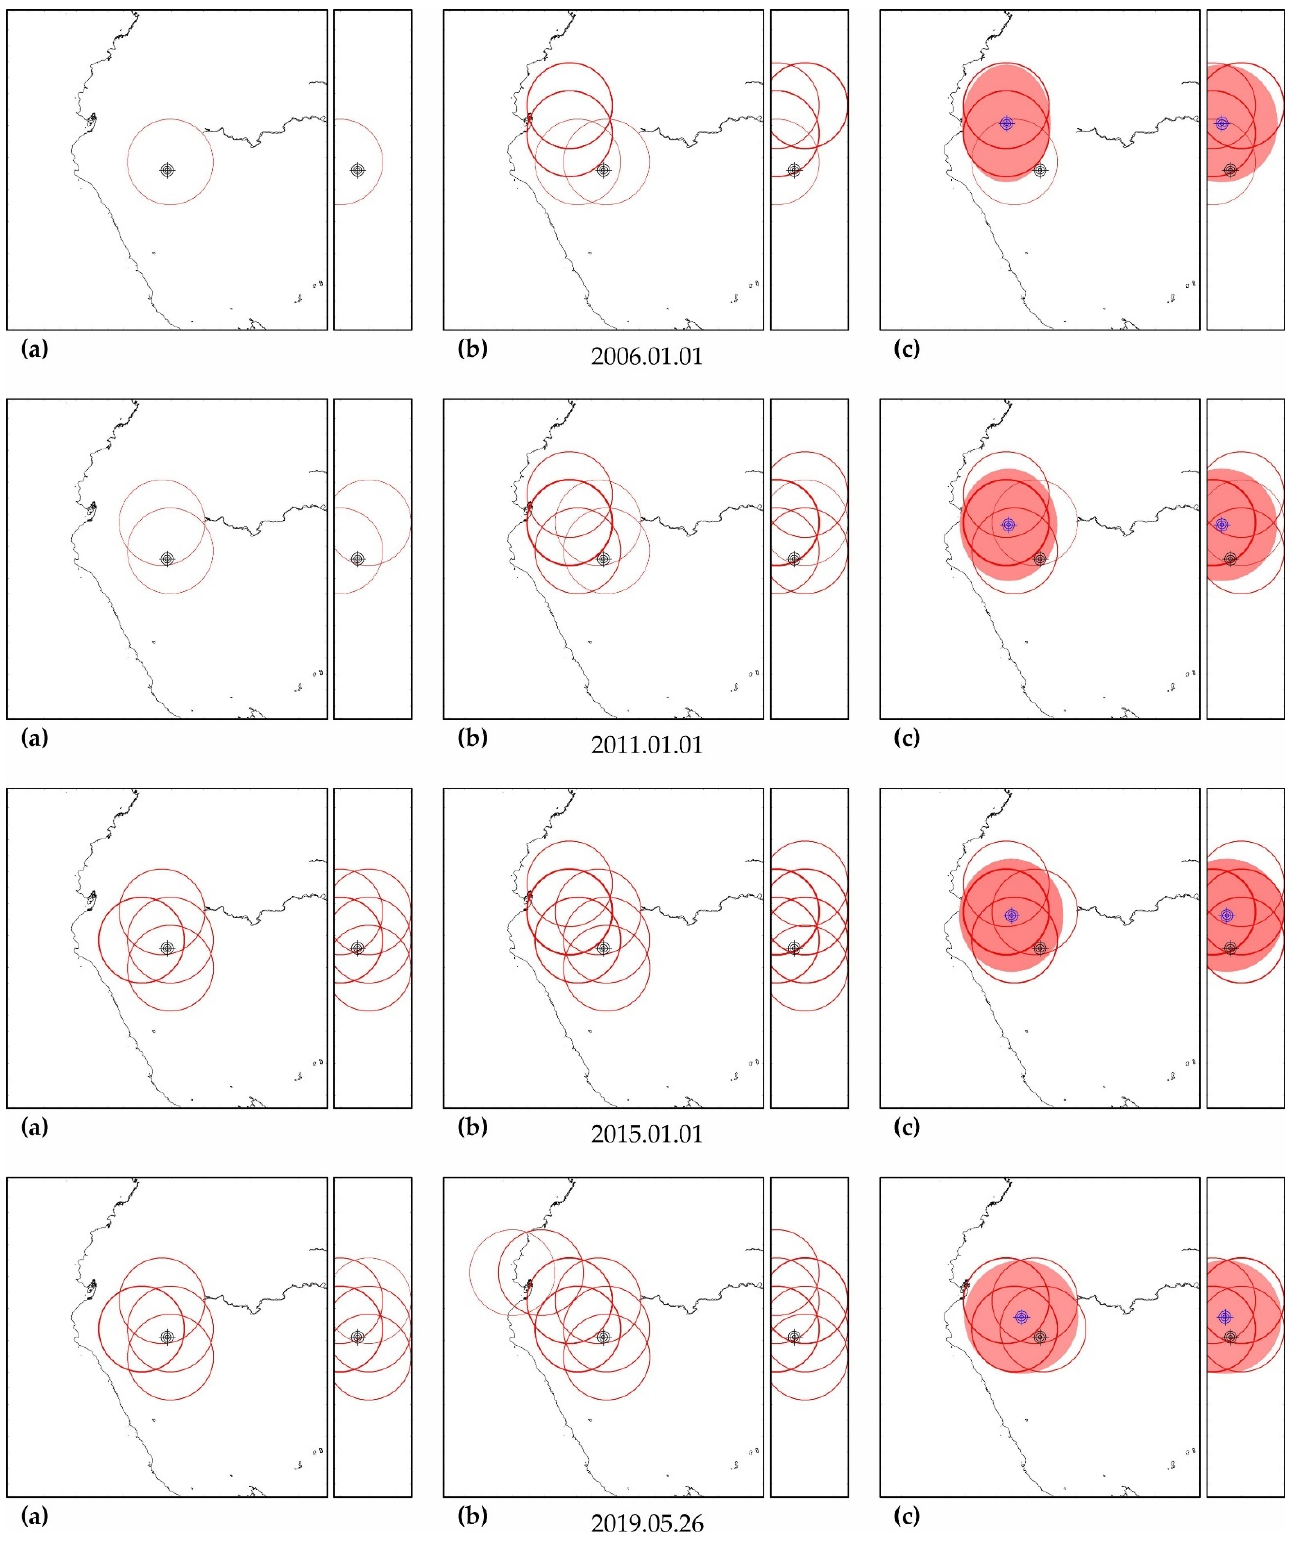
Figure A15. Zones of factual predictability for the earthquake of 26 May 2019 ( a ), identified zones with similar development according to the parameters of the DSDNP equation ( b ) and a cluster of zones of the greatest activity ( c ) used to calculate the time and place of a precedent earthquake (see Figure A3 for explanations).